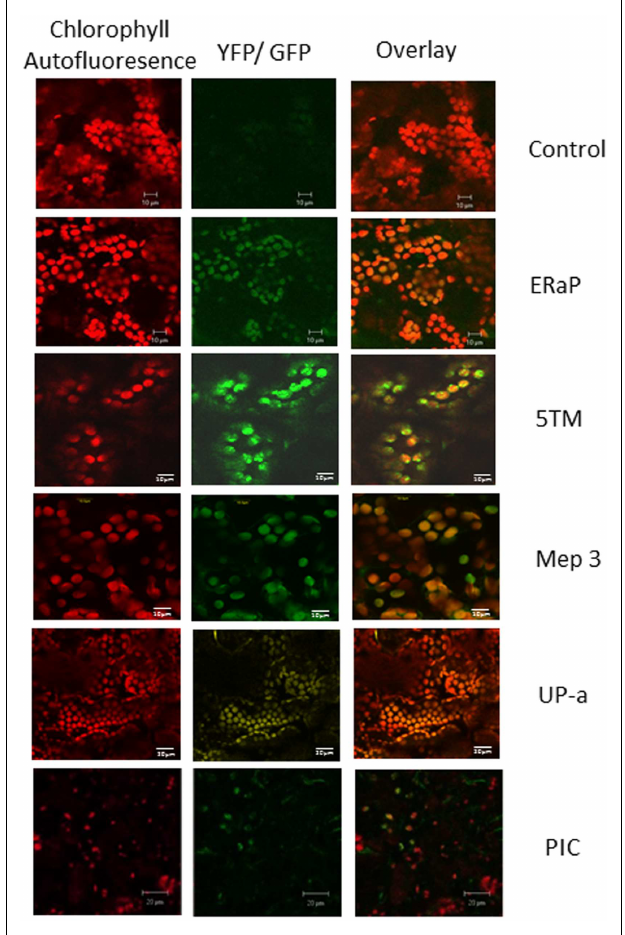
FIGURE 4 | Localization of chloroplast envelope proteins with C-terminal GFP orYFP tags that were transiently expressed in Nicotiana tabacum. The first column shows chlorophyll autofluorescence, the second column GFP orYFP fluorescence, column three shows the overlay. Protein names (as used in Table 1 ) are indicated on the right of each row.